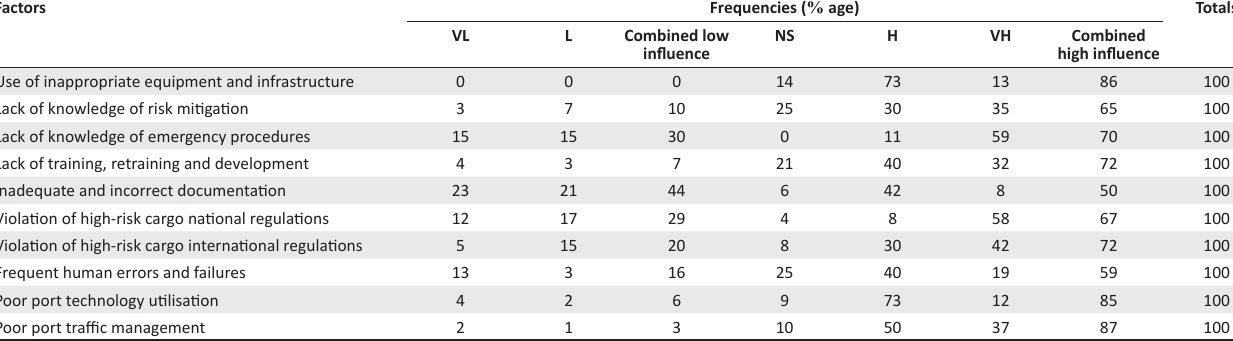
TABLE 3: Level of factors hindering the effectiveness of high-risk cargo logistics.